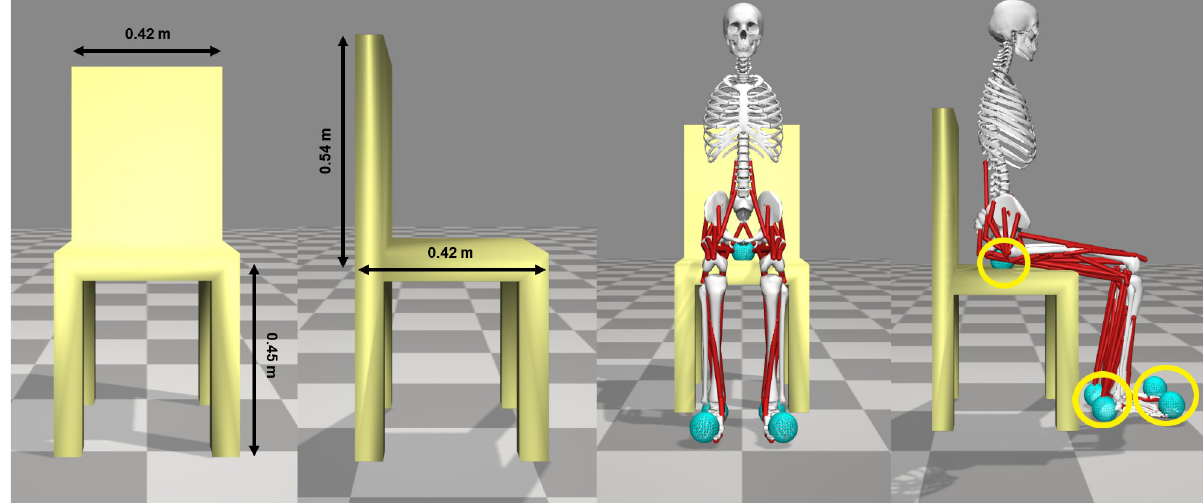
Fig 2. Simulation scenario. Measurements of the chair, musculoskeletal model and contact geometry (yellow circles).